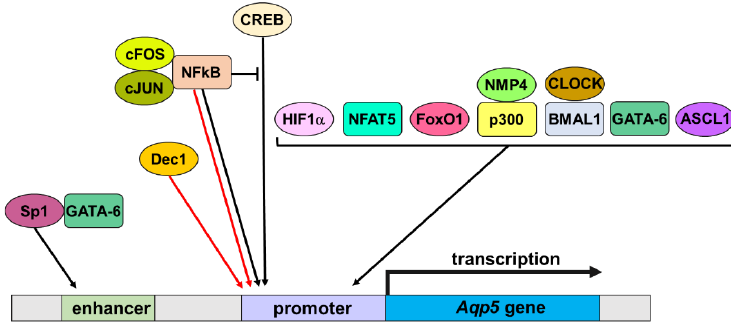
Figure 1. Transcription factors regulating Aqp5 transcription. ASCL1: Achaete-Scute Family BHLH Transcription Factor 1; BMAL1: Basic Helix-Loop-Helix ARNT Like 1; CLOCK: circadian locomotor output cycles kaput protein; CREB: PKA/cAMP Response Element-binding protein; Dec1 : differen- tiated embryo chondrocyte expressed gene 1; FoxO1: Forkhead box O1; GATA-6: GATA Binding Protein 6; HIF1 α : hypoxia-inducible factor-1; NFAT5: nuclear factor of activated T cells 5; NFkB: Nu- clear factor kappa B; NMP4: Nuclear matrix protein 4—also named Zinc Finger Protein 384 (ZNF384). Black and red arrows, respectively, indicate a positive or negative effect on Aqp5 gene transcription. The black bar indicates an inhibitory